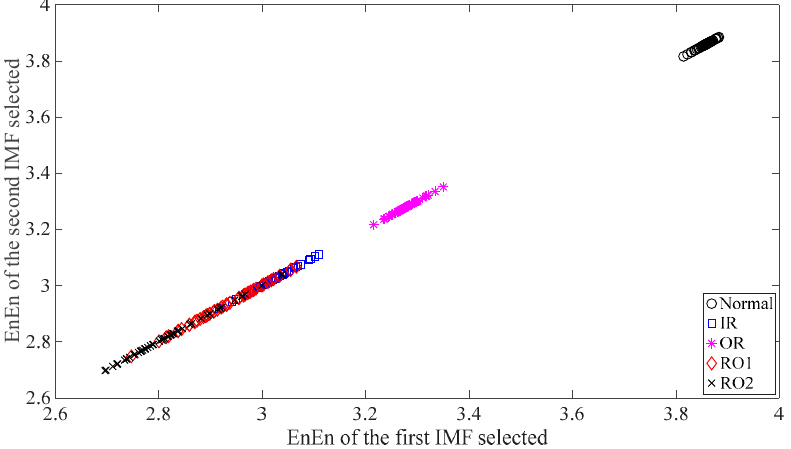
Figure 20. Two-dimensional EnEn of the two IMFs most correlated with the original data for each of the five types of roller-bearing condition. In this case, the first IMFs are selected for use.